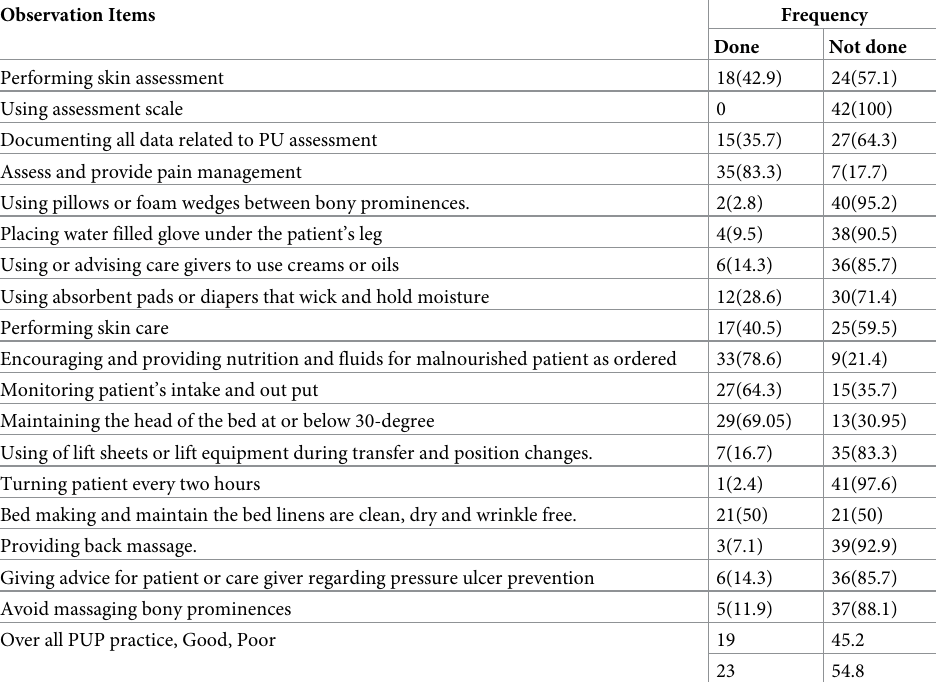
Table 4. Observation checklist for pressure ulcer prevention practice among nurses working in public hospitals of Harari regional state and Dire Dawa city administration, Eastern Ethiopia, 2018 (n = 42). Observation